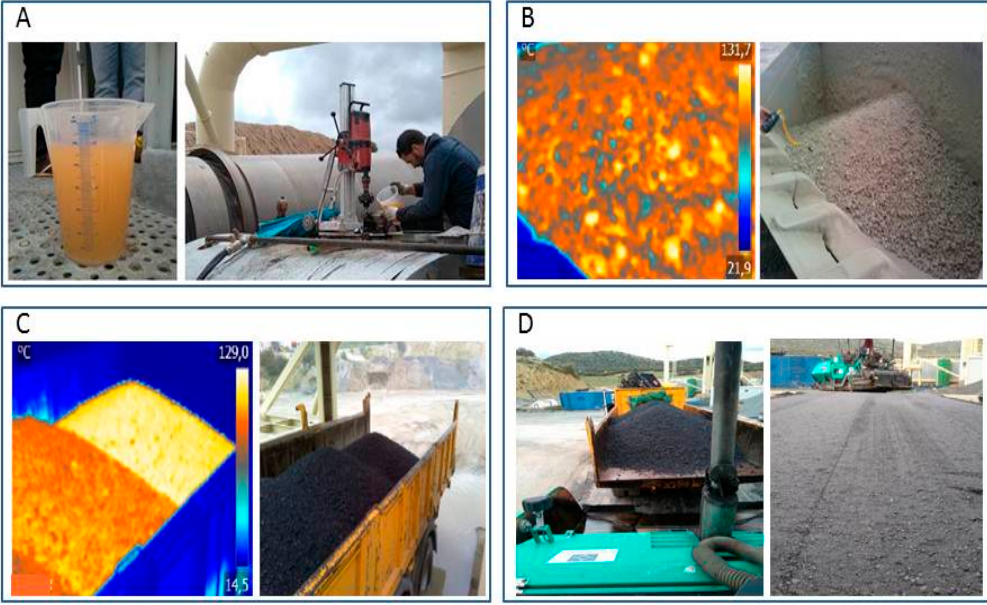
Figure 9. Visual appearance of the process for manufacturing the WMA with the chemical additive. ( A ) incorporation of additive to bitumen; ( B ) aggregates temperature; ( C ) WMA temperature; ( D ) spreading and compaction of the WMA. Table 4. Results recorded for the HMA and WMA manufactured in a real asphalt plant.